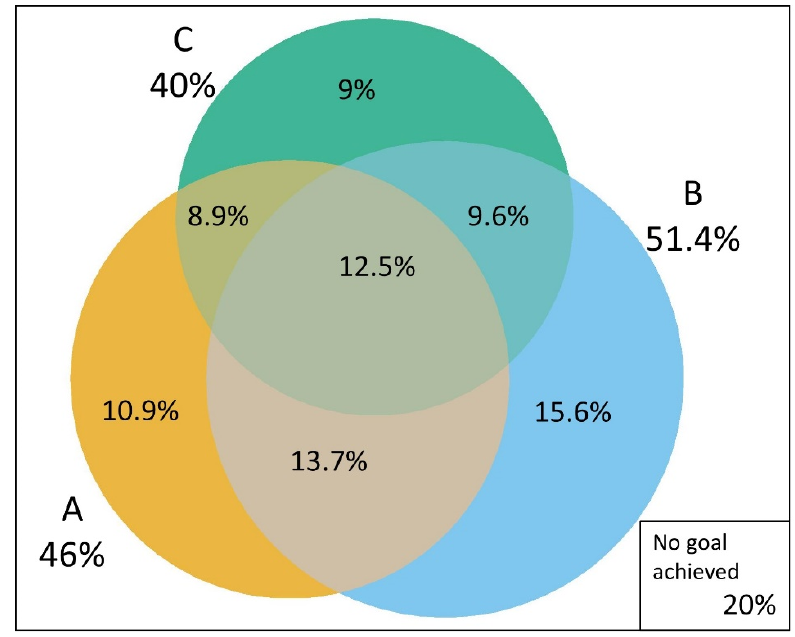
Figure 3. Venn diagram showing the overlap in in the attainment of treatment goals in individuals with self-reported diabetes: A1C (A), blood pressure (B) and cholesterol (C). Laboratory subsample, Brazilian National Health Survey